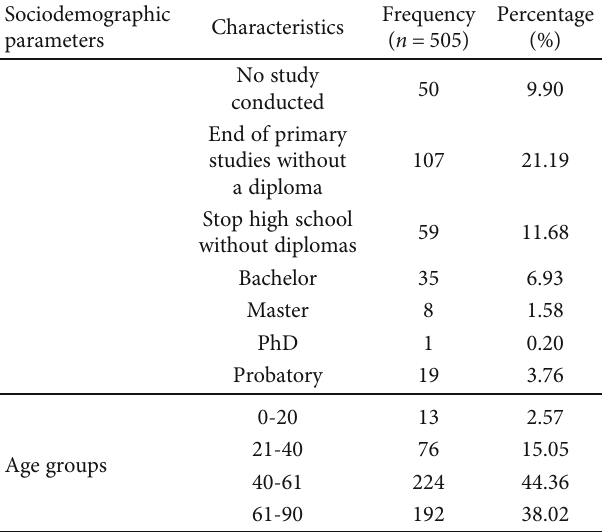
Table 1: Sociodemographic characteristics of total study